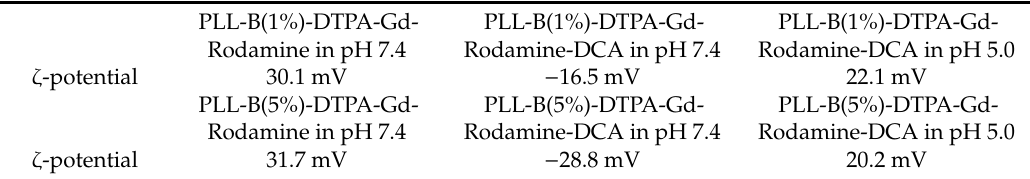
Table 1. ζ -potential of PLL-B-DTPA-Gd-Rodamine and PLL-B-DTPA-Gd-Rodamine-DCA in different conditions.